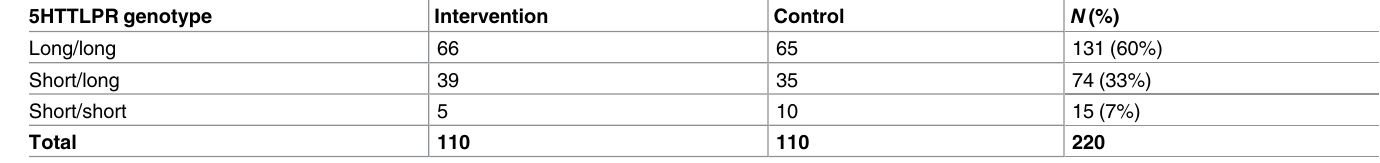
Table 1. 5HTTLPR genotype results for the 220 adolescents with both genotype and attachment data, half of whom receivedthe intervention and half of whom did